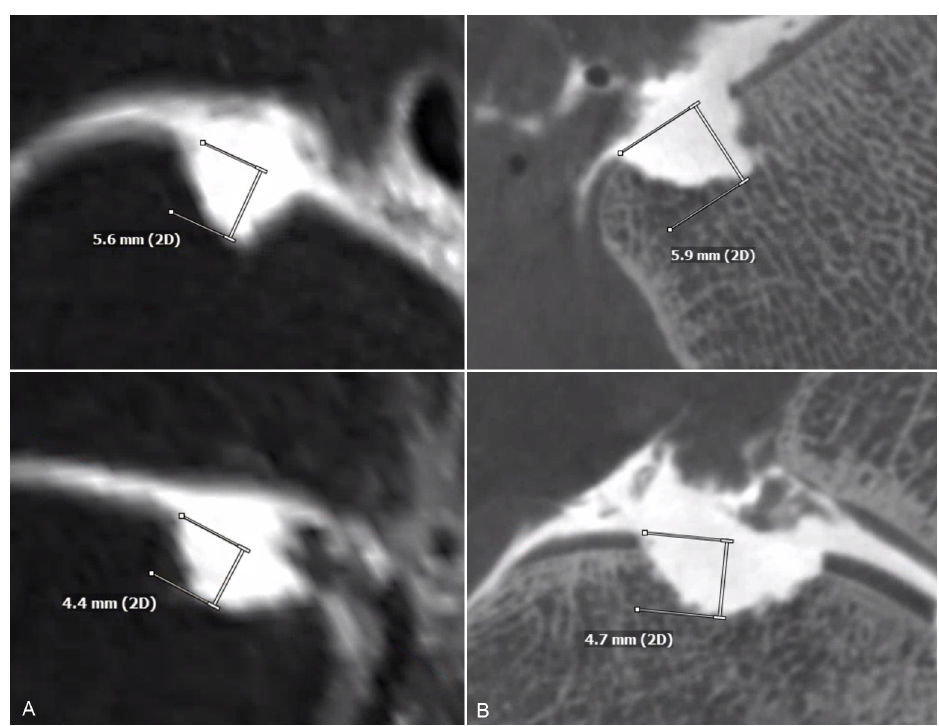
Fig 3. 3D MR- and flat panel CT-arthrography measurements. Multiplane reconstruction of one single defect in the isotropic 3D space MR-sequence (A) with the corresponding planes in flat panel computed tomography arthrography (B) with marked depth measurements. The margins of the artificially created defect are clearly defined against the intra-articular contrast agent and the defect dimensions can be measured.